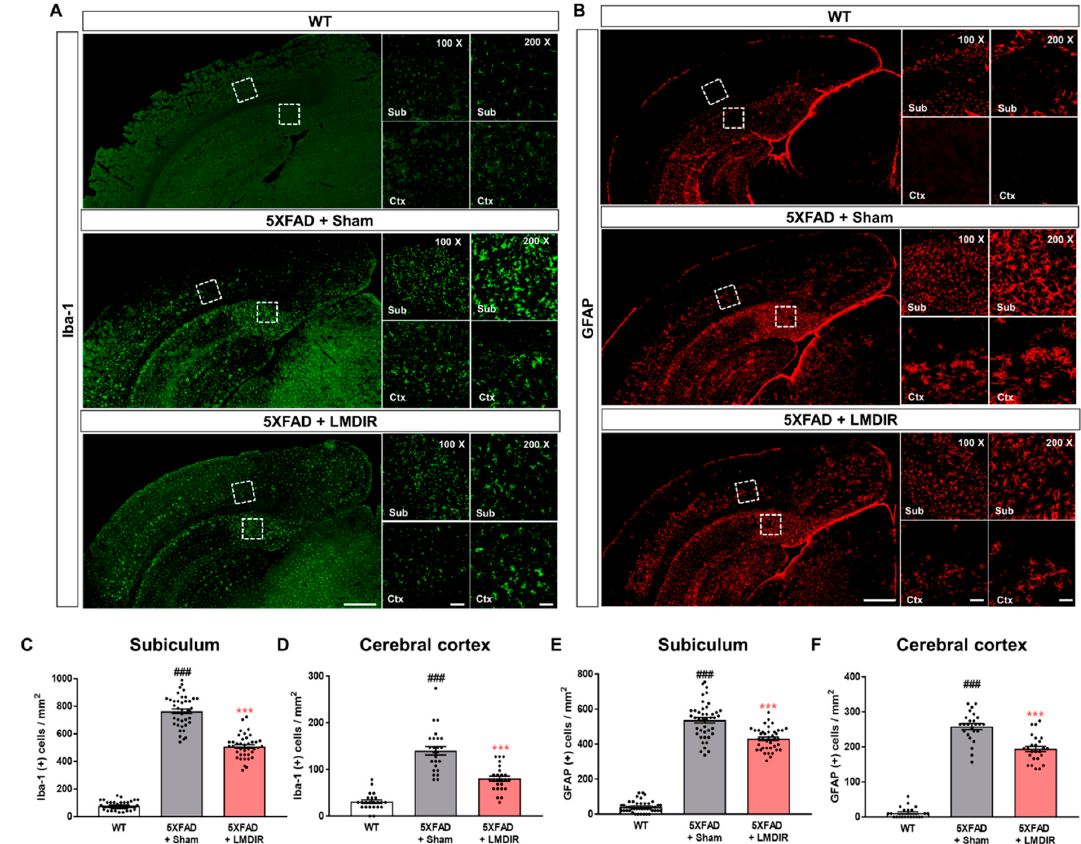
Figure 3. Inhibitory effect of LMDIR on neuroinflammation in the subiculum and cerebral cortex of 5XFAD mice. ( A ) Representative images of immunofluorescent staining of the subiculum and cerebral cortex for Iba-1, a marker of microglia. ( B ) Representative images of immunofluorescent staining of the subiculum and cerebral cortex for GFAP, a marker of astrocytes. ( C , D ) The number of Iba-1 (+) cells was significantly higher in the subiculum and cerebral cortex of 5XFAD mice than that of the WT mice. In contrast, the number of Iba-1 (+) cells was significantly lower in the subiculum and cerebral cortex of LMDIR-exposed 5XFAD mice than that of the sham-exposed 5XFAD mice. ( E , F ) The number of GFAP (+) cells was significantly higher in the subiculum and cerebral cortex of 5XFAD mice than the WT mice. However, the number of GFAP (+) cells was significantly lower in the subiculum and cerebral cortex of LMDIR-exposed 5XFAD mice than that of the sham-exposed 5XFAD mice. Data are presented as mean ± SEM ( n = 7 in each group). ### p < 0.001: WT mice versus sham-exposed 5XFAD mice. *** p < 0.001: sham-exposed 5XFAD mice versus LMDIR-exposed 5XFAD mice. Scale bar = 50 and 100 μ m (Sub and Ctx) or 500 μ m (hemisphere). LMDIR, low–moderate dose ionizing radiation; Iba-1, ionized calcium-binding adaptor molecule 1; GFAP, glial fibrillary acidic protein.